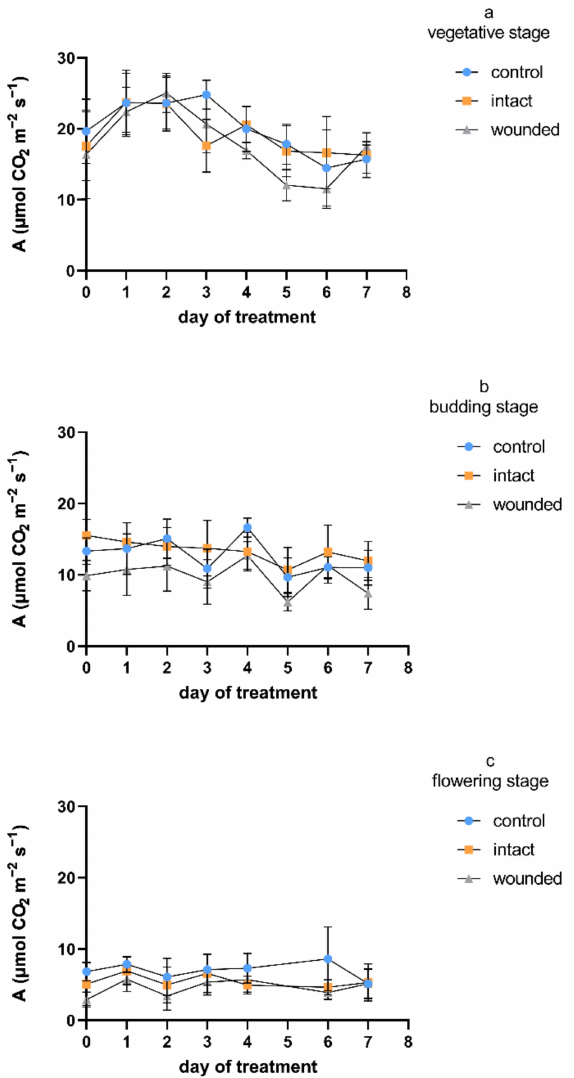
Figure 1. Photosynthetic rate of Ocimum basilicum var. minimum L. versus leaf wounding im- posed at the ( a ) vegetative, ( b ) budding, ( c ) or flowering stage. Data are means ( n = 7) ± standard deviation